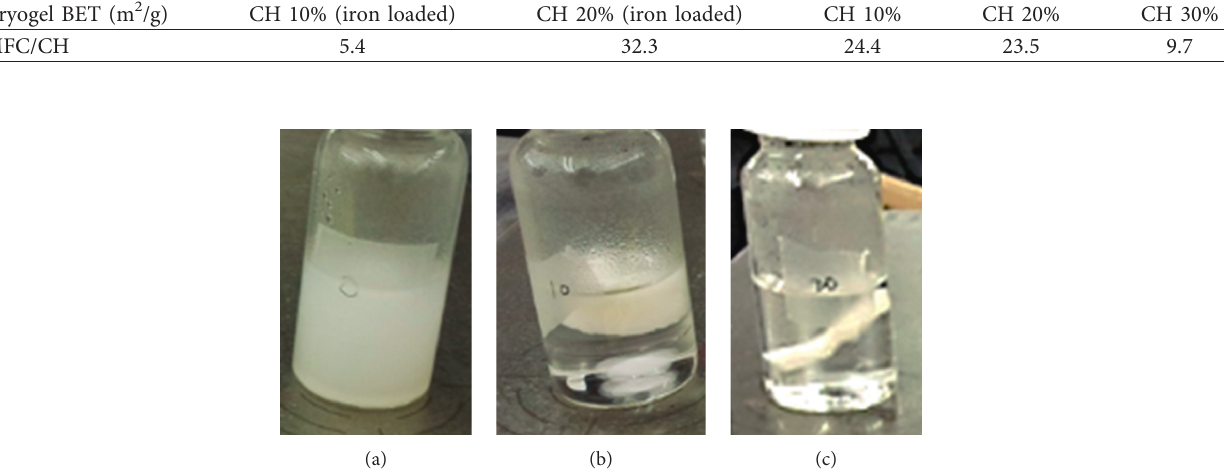
Figure 1: Cryogels produced from MFC and chitosan and their stability in water at loadings of chitosan (CH) of 0% (a), 10% (b), and 20% (c).